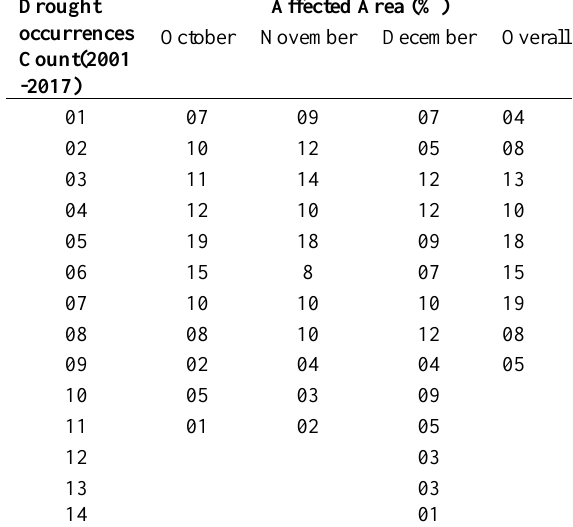
Table 2. VCI based drought affected area (%) and its area- specific frequencies(cid:10)